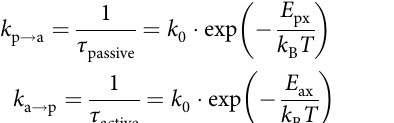
and the energetic difference between the states Δ E ¼ E Both parameters are presented in the scheme in Fig. 5a – b.